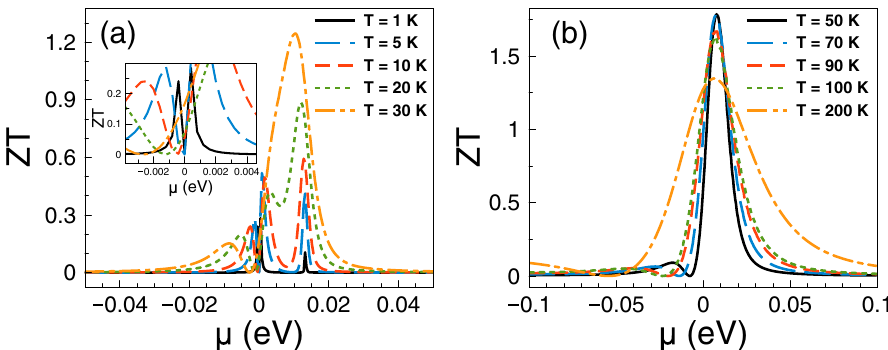
Figure 5. ZT versus chemical potential for gapless bilayer graphene single barriers at different temperatures: ( a ) from 1 to 30 K and ( b ) from 50 to 200 K. The single barrier structural parameters are the same as in the preceding figures. As in the case of the Seebeck coefficient, the charge neutrality point dominates the ZT characteristics at low temperatures, while the Fano resonances energy region become preponderant as the temperature rises.